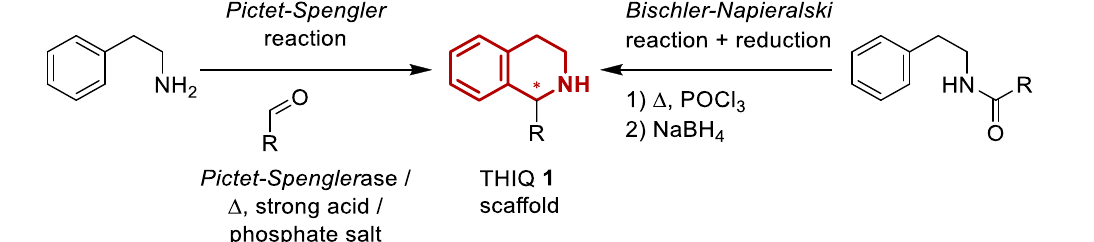
Scheme 1. Access to 1,2,3,4-Tetrahydroisoquinolines 1 by the Pictet–Spengler reaction or Bischler-Napieralski reaction with subsequent reduction.